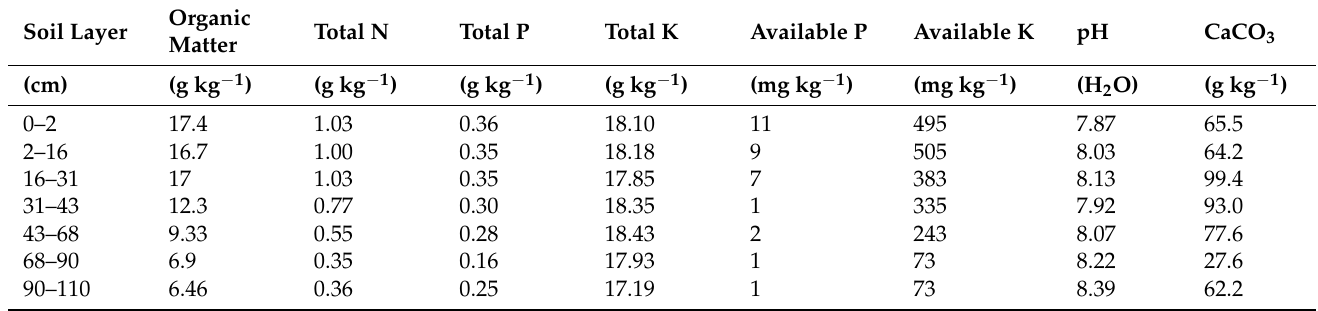
Table 1. Initial soil physicochemical characteristics at the experimental site in